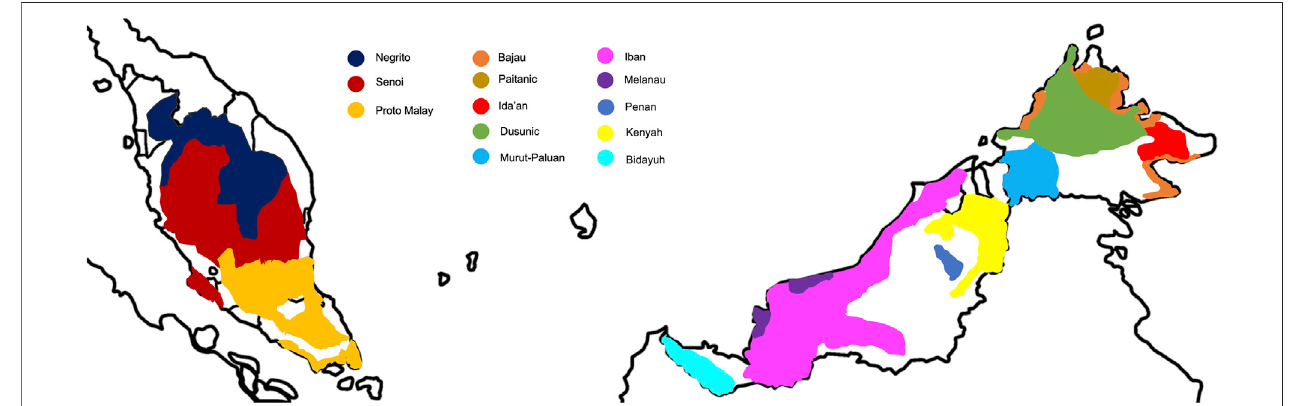
FIGURE 1 | Distribution of the major native populations from Peninsular Malaysia and